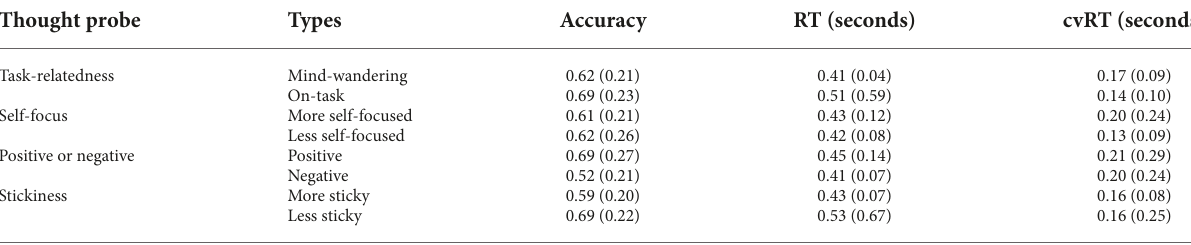
TABLE 3 Task performance of the “Nogo” trials as a function of responses on the different thought probes. Thought probe